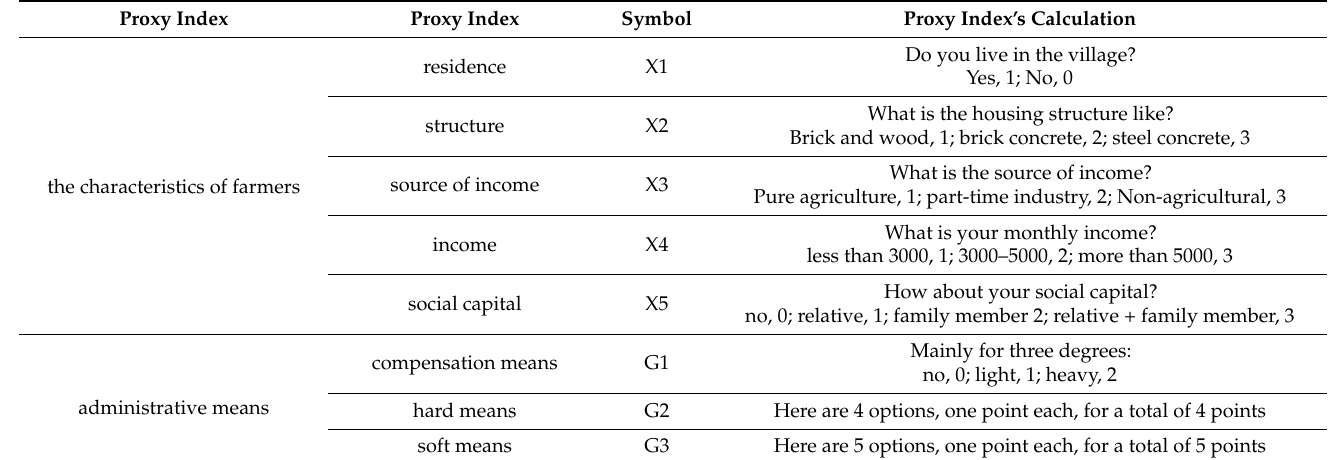
Table 4. Evaluation of main variables.